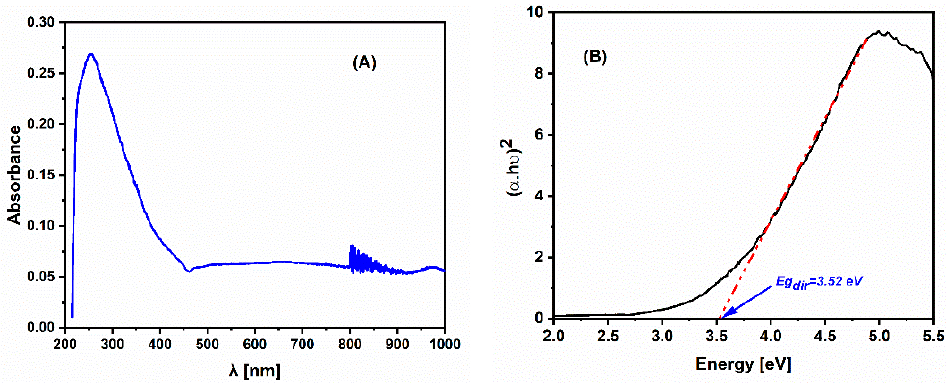
Figure 2. UV–Visible–near-IR absorbance of ZrP 2 O 7 ( A ) and Tauc’s plot ( B